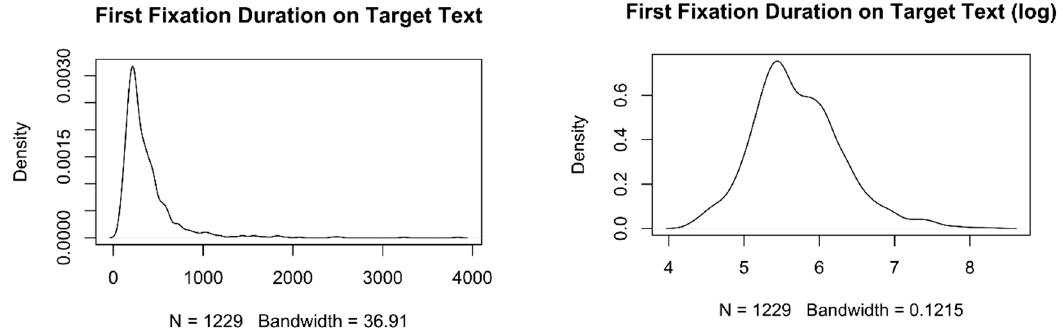
Figure 15. Density plot ( left ) and log-transformed density plot ( right ) for target text first fixation durations.